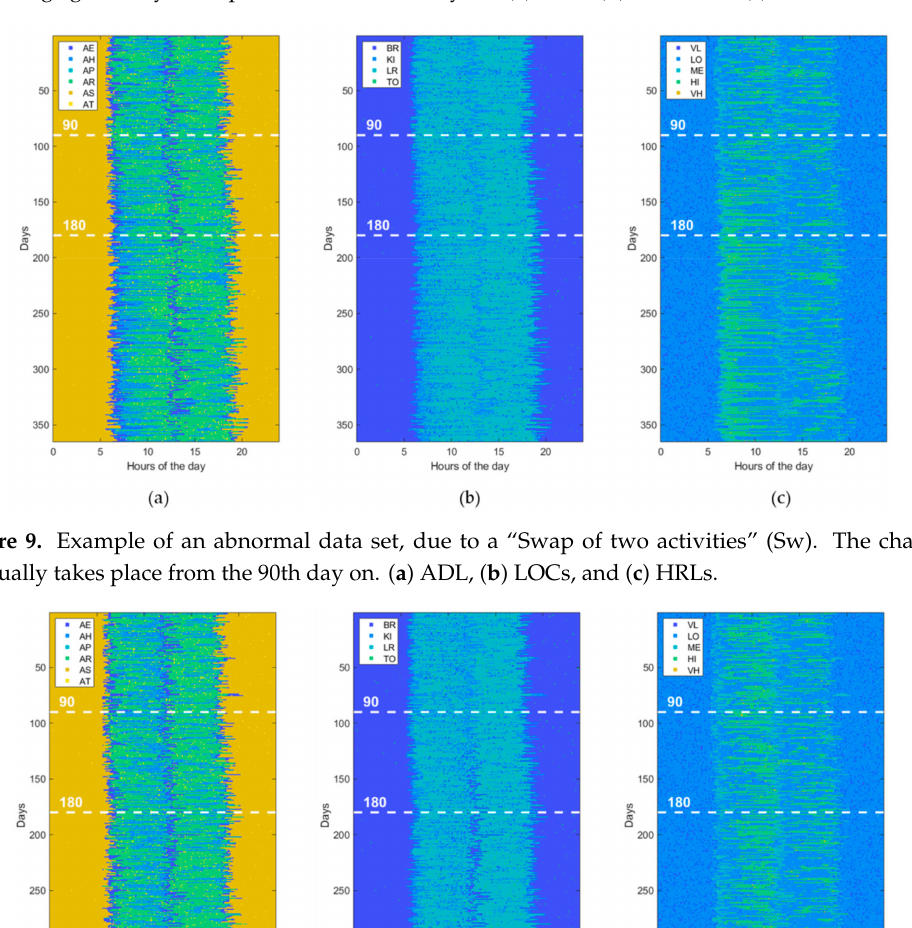
Figure 8. Example of an abnormal data set, due to a change in “Disappearing of activity” (Di). The change gradually takes place from the 90th day on. ( a ) ADL, ( b ) LOCs, and ( c ) HRLs.